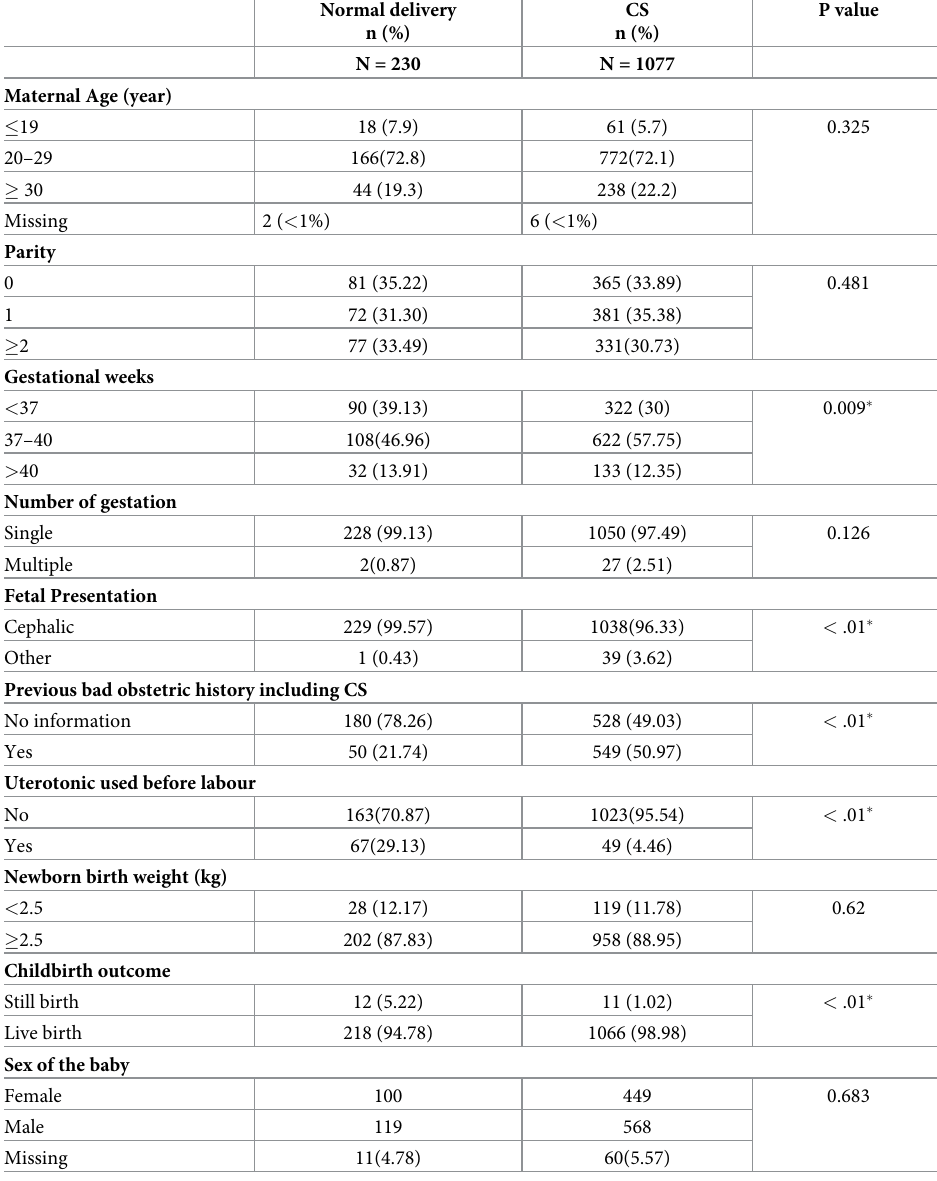
Table 2. Characteristics of study respondents by mode of delivery in for-profit private hospitals in urban Bangladesh.